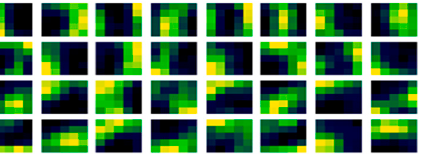
Figure 7. Learned filter weight-adaption updates with the proposed method.